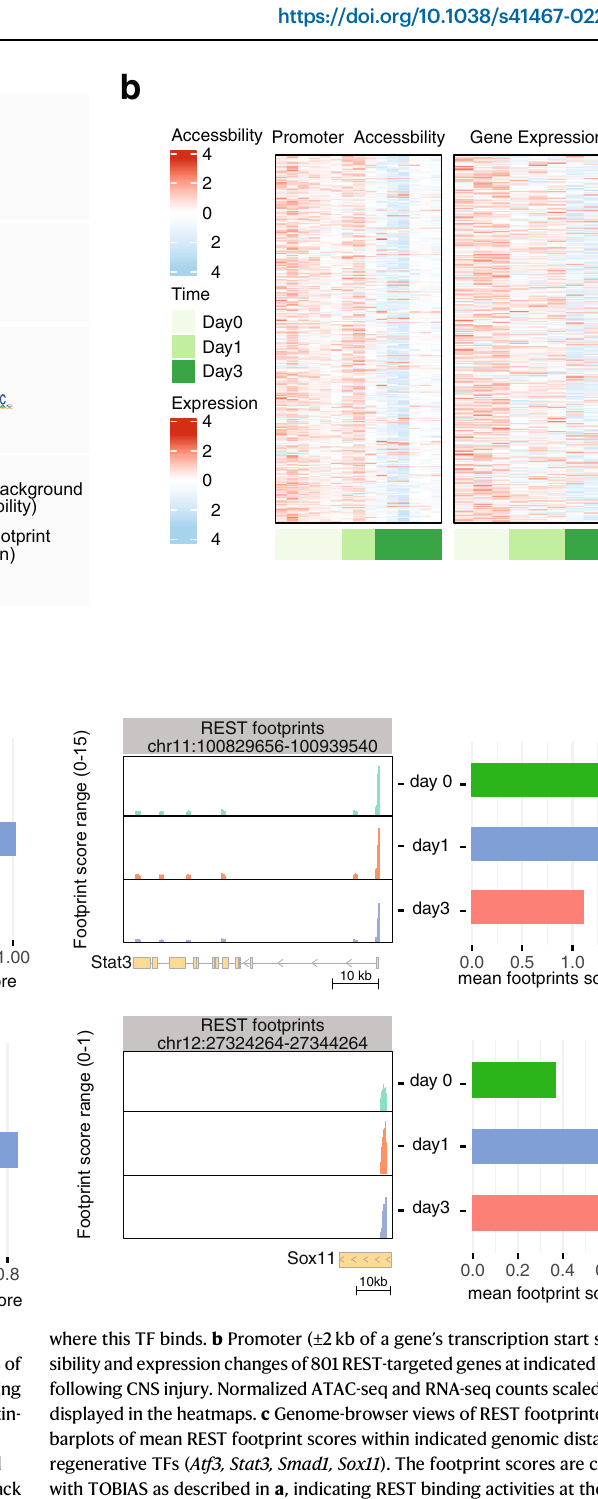
Asanalternativeapproach(SupplementaryFig.10a)toinvestigate the role of REST in vivo, we deleted it in mature RGCs via AAV2-Cre- driven recombination in mice with homozygous conditional REST alleles and the same TdTomato reporter line (REST fl x/ fl x ; STOP fl x/ fl x